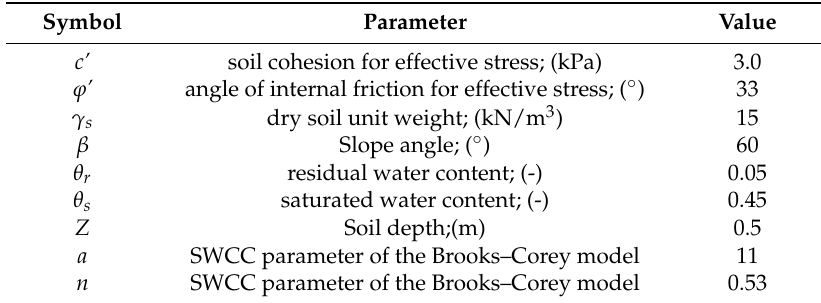
Table 1. Soil parameters for the slope stability analysis. SWCC denotes soil water characteristic curves. Symbol Parameter Value c’ soil cohesion for effective stress; (kPa) 3.0 ϕ ’ angle of internal friction for effective stress; ( ◦ ) 33 γ s dry soil unit weight; (kN/m 3 ) 15 β Slope angle; ( ◦ ) 60 θ r residual water content; (-) 0.05 θ s saturated water content; (-) 0.45 Z Soil depth;(m) 0.5 SWCC parameter of the Brooks–Corey model n SWCC parameter of the Brooks–Corey model